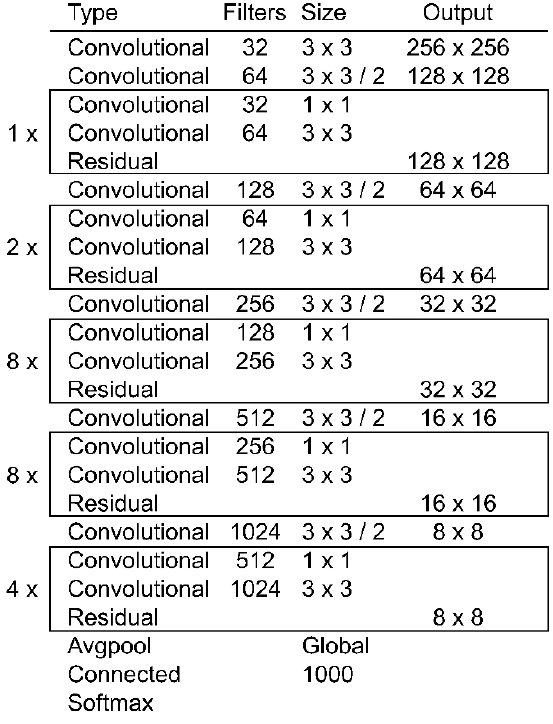
Figure 2. Architecture of DarkNet53.